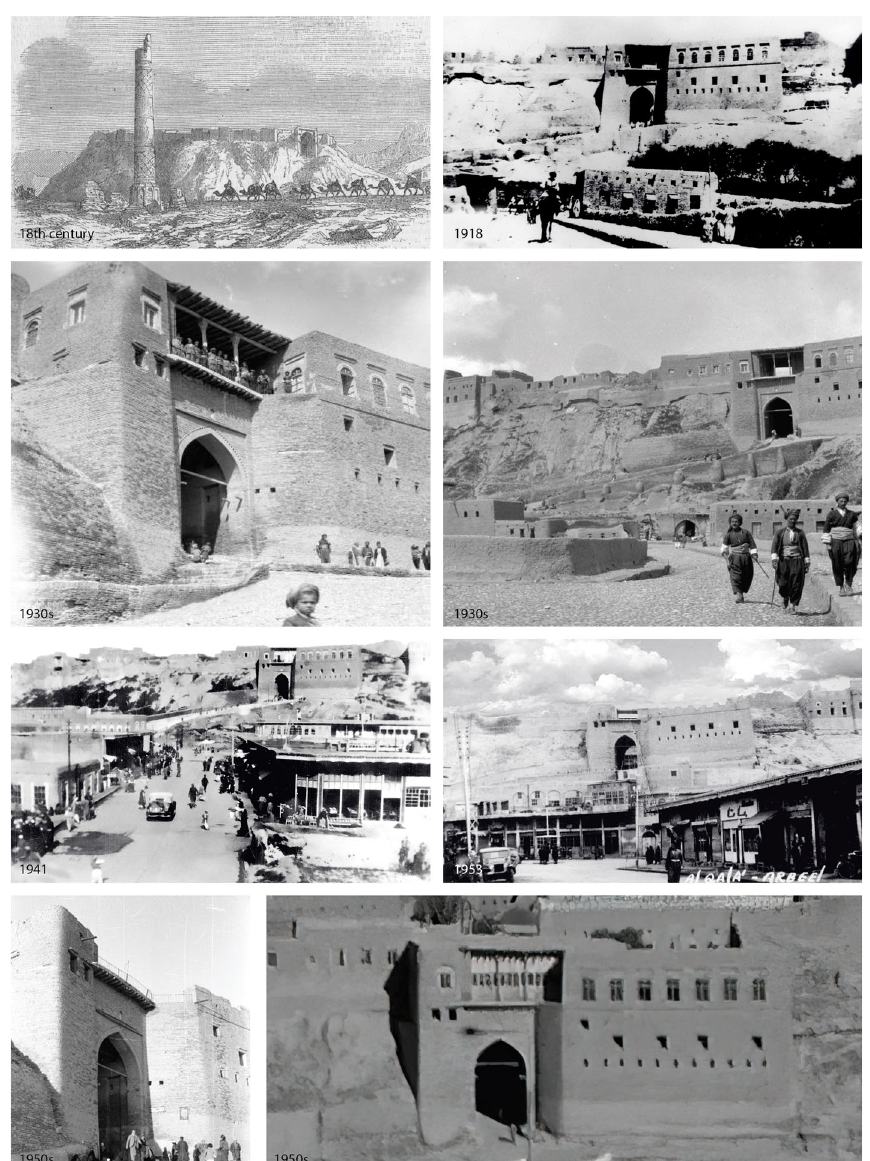
Fig. 3 The grand gate historical modifications between the end of the 19th century and the middle of the 20th century (Source: HCECR